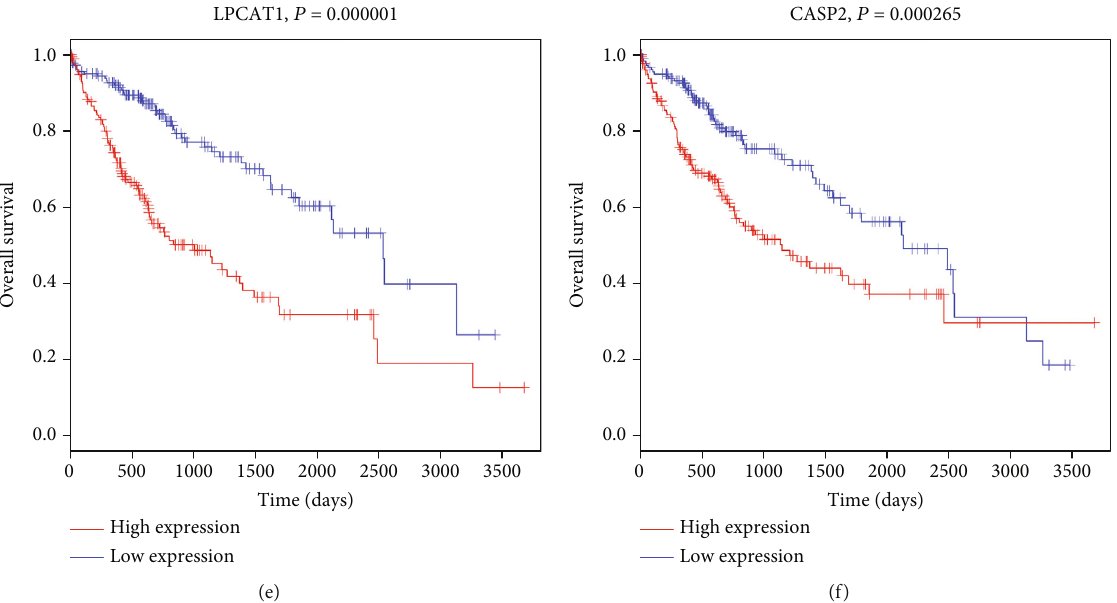
Figure 3: Prognosis prediction for di ff erentially expressed ceRNAs. Kaplan-Meier survival curves for top two lncRNAs (a, b), miRNAs (c, d), and mRNAs (e, f) associated with overall survival. Horizontal axis, overall survival time, days; vertical axis, survival function. Red represents high expression samples, and blue represents low expression samples. ceRNA: competing endogenous RNA; lncRNA: long noncoding RNA; miRNA: microRNA; mRNA: messenger